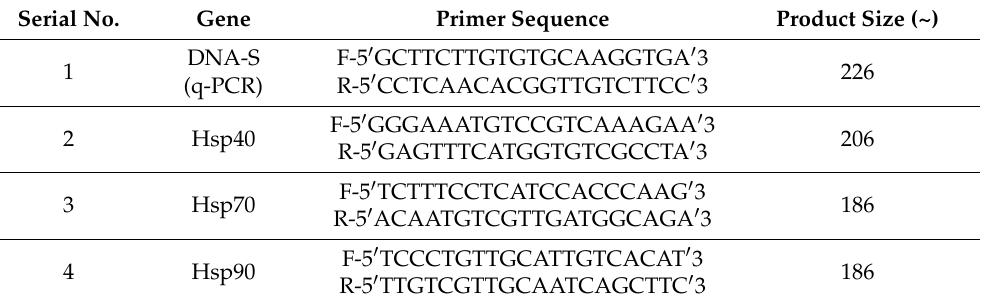
Table 1. Sequences of the designed primers for the coat protein gene of BBTV and Hsp genes of P. nigronervosa